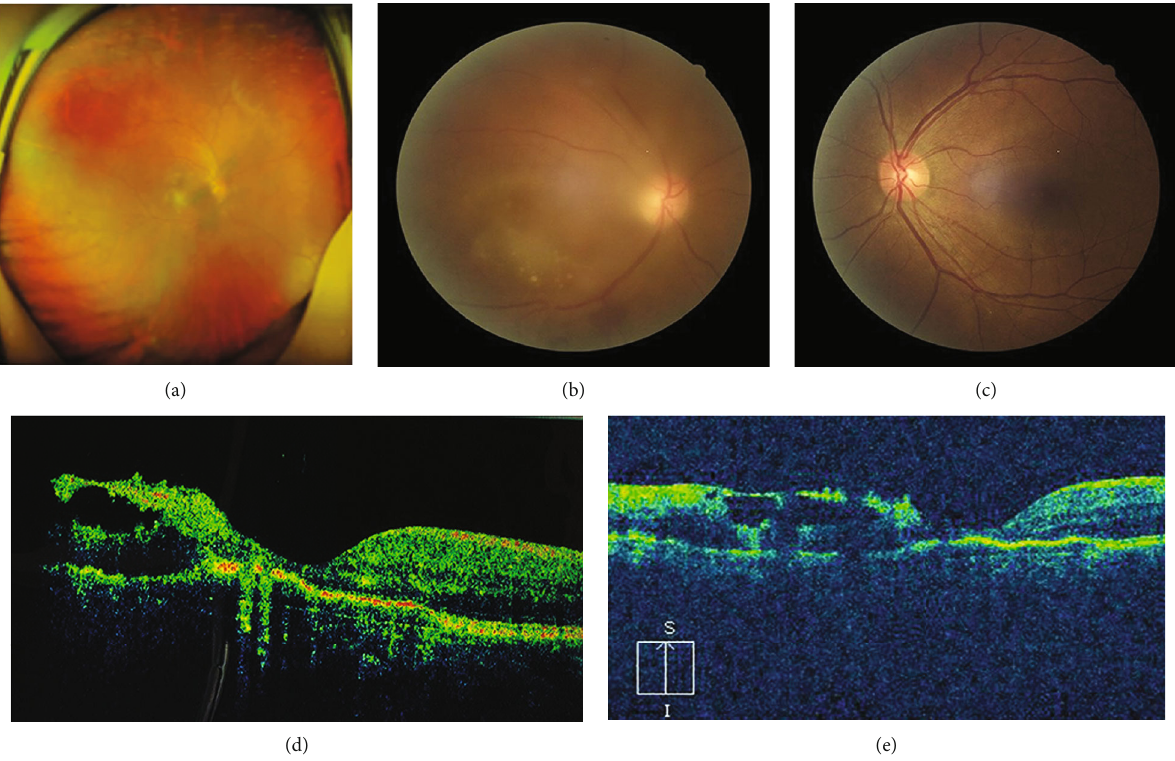
Figure 1: In fl ammation was present in the right eye. (a) The fundus was opaque, and exudation and hemorrhage could be seen in the macular and inferonasal peripheral retina. (b) Dense vitreous opacities obscured the visualization of the fundus of the right eye. Chorioretinitis with exudation and hemorrhage was seen in the macular. (c) Normal fundus of left eye. (d, e) OCT showed an epiretinal membrane above the inner retinal surface of macular fovea and pigment epithelial detachment